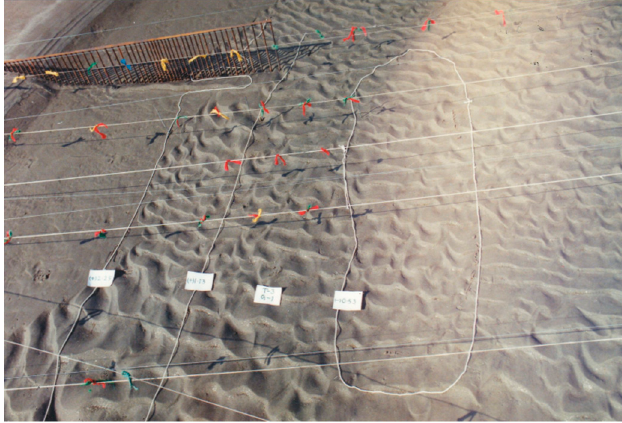
Figure 9. Small local scour hole (0 m to 1 m) near a pile row without bed protection or falling apron, only some scour around the piles, test C-T2-1 in Compagnie Nationale du Rhone ( CNR), France [40], (photograph taken by CNR for project FAP 21/22).